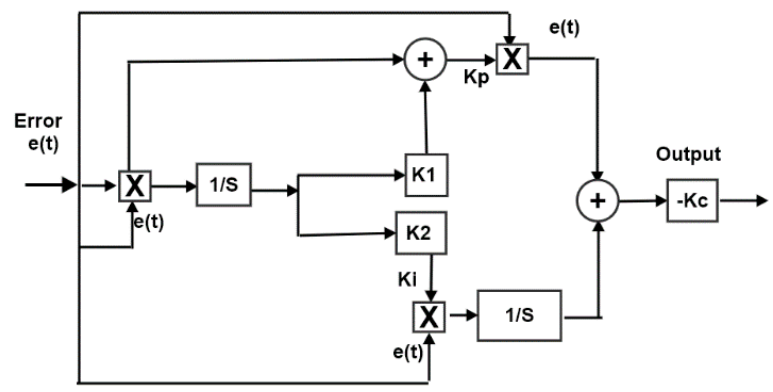
Figure 10. Block diagram representation of the adaptive PI controller.